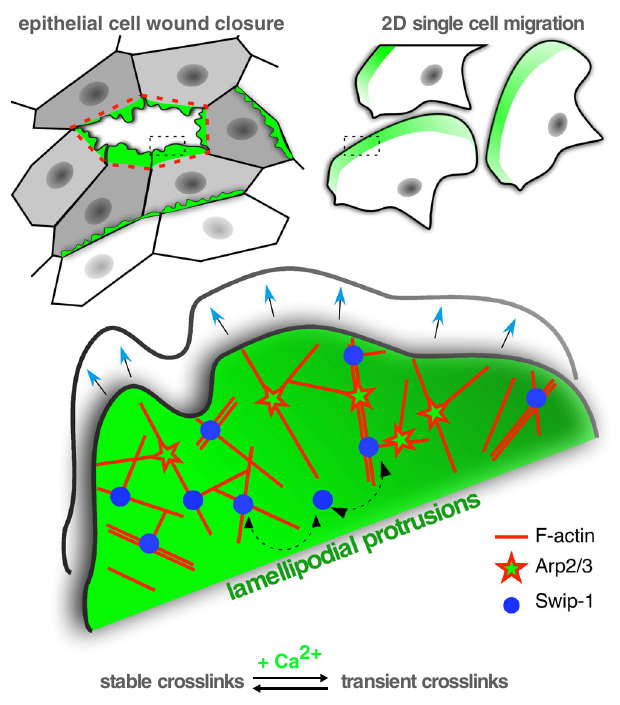
Fig. 7 EFhD2/Swip-1 cross-linked lamellipodial actin networks drive single-cell migration and epithelial wound closure. Schematic showing the proposed role of EFhD2/Swip-1 in regulating lamellipodial actin